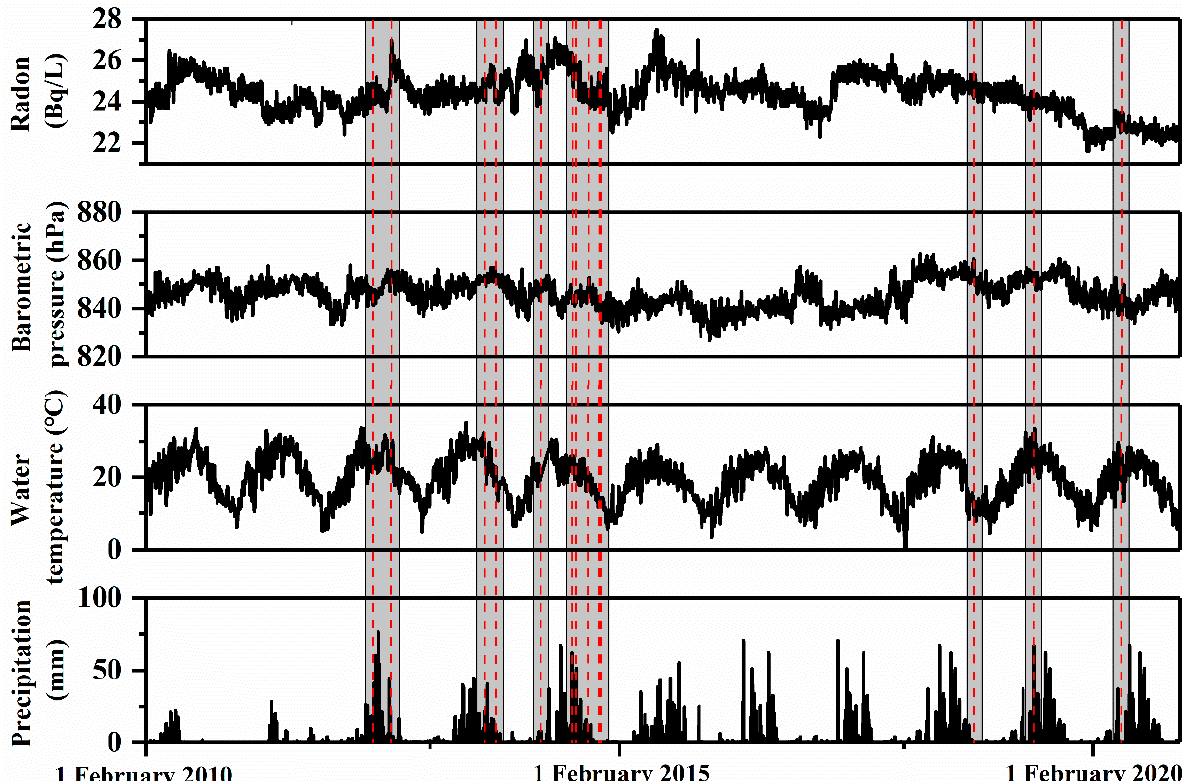
Figure 2. Radon, barometric pressure, water temperature, and precipitation data within well #32 from 1 February 2010 to 31 December 2020; the gray area represents the period during seismic activity, and the rest of area represents the period without earthquakes (these data are used to train the EMD-LSTM model); the red dotted lines indicate the time of earthquake occurrence.